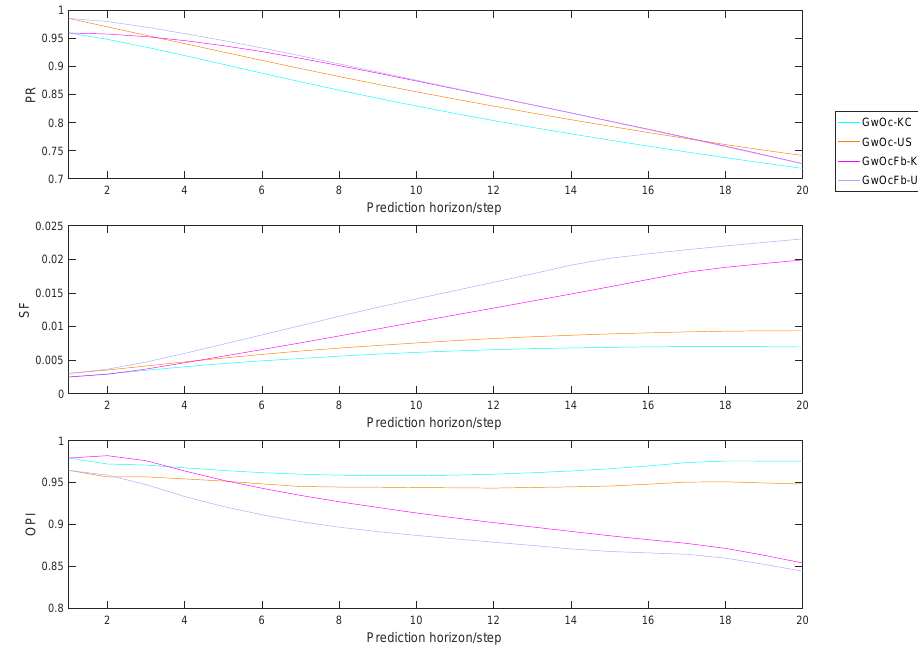
Figure 12. Comparison of the prediction performance of the GwOc-KC, GwOc-US, GwOcFb-KC, and GwOcFb-US methods (left hip joint data in sagittal